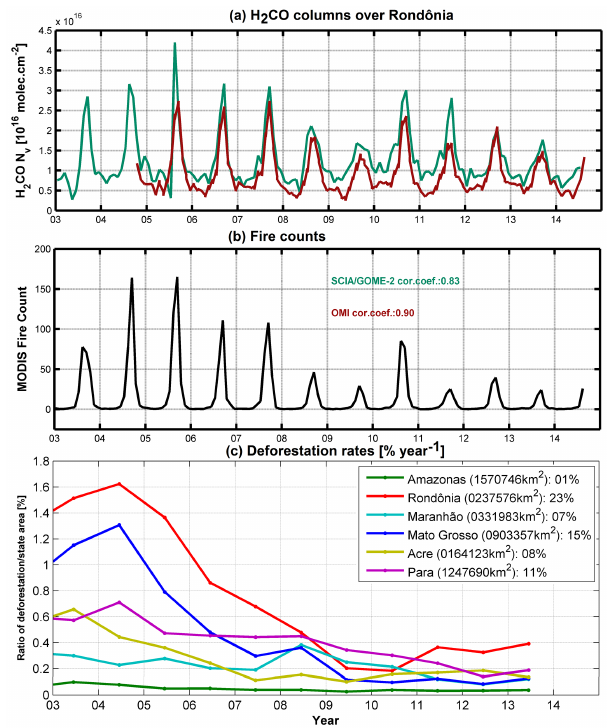
Figure 18. (a) Monthly averaged H 2 CO vertical columns from SCIAMACHY/GOME2 (in green) and from OMI (in red) (first panel) and (b) MODIS fire count (second panel) over the Rondônia Brazilian state. Inset values are the correlation coefficient between the satellite H 2 CO columns and the fire counts. (c) Reported yearly deforestation rates in selected Brazilian states, relative to their re- spective surfaces (third panel; source: Brazil INPE). Inset values are the total surface of the state and the total rate of deforestation between 1988 and